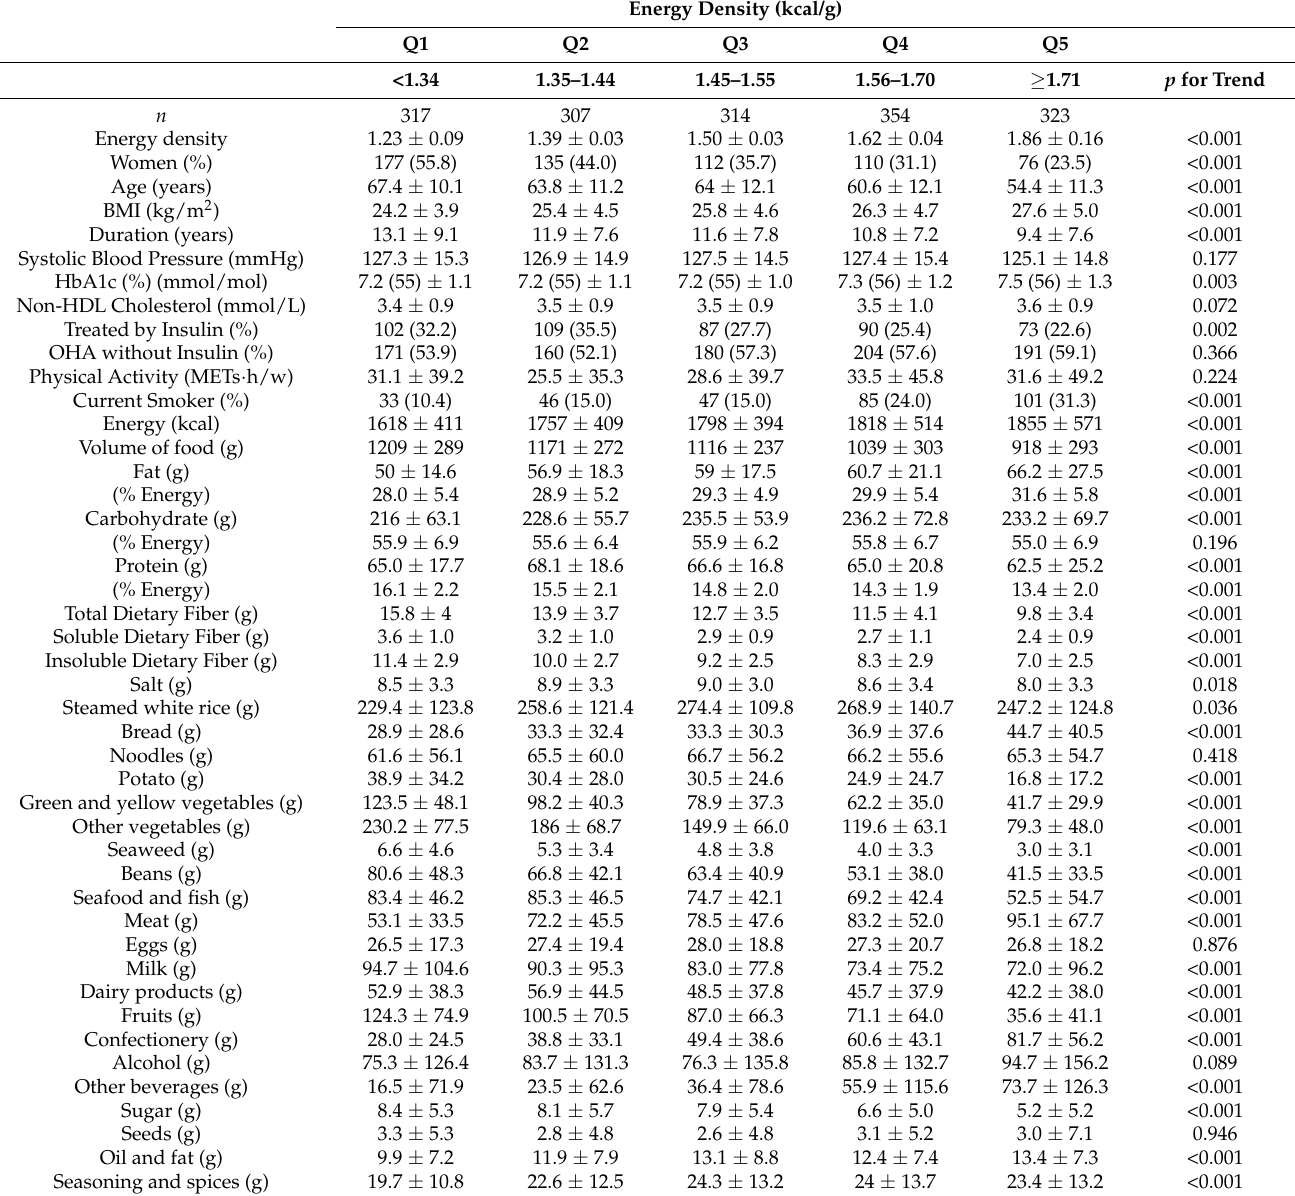
Table 1. Characteristics of participants, nutritional factors, and food groups according to quintiles of energy